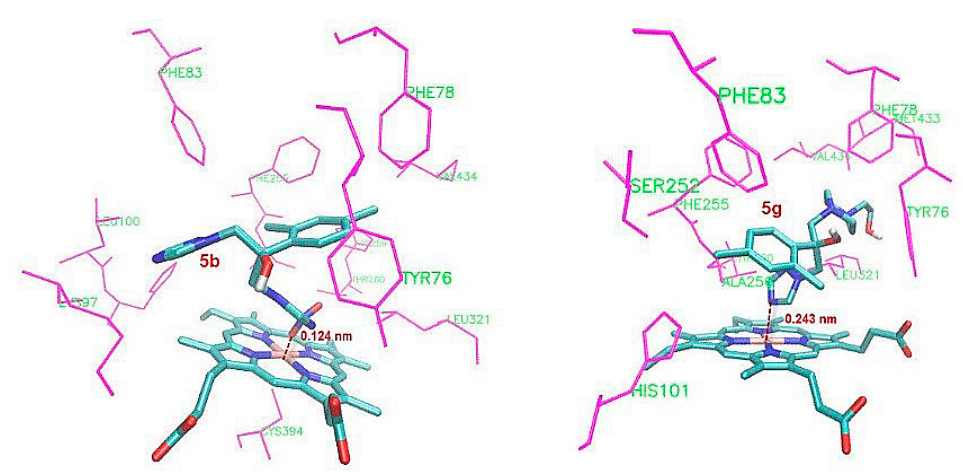
Figure 1. Visualizing the active site in the presence of ligands: left ( 5b ), right ( 5g ).